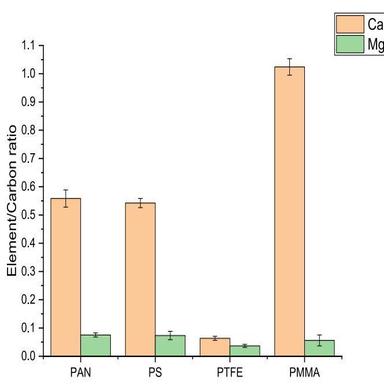
Element (Ca and Mg) to carbon-ratio of the four different polymer samples detected with ICP-OES.